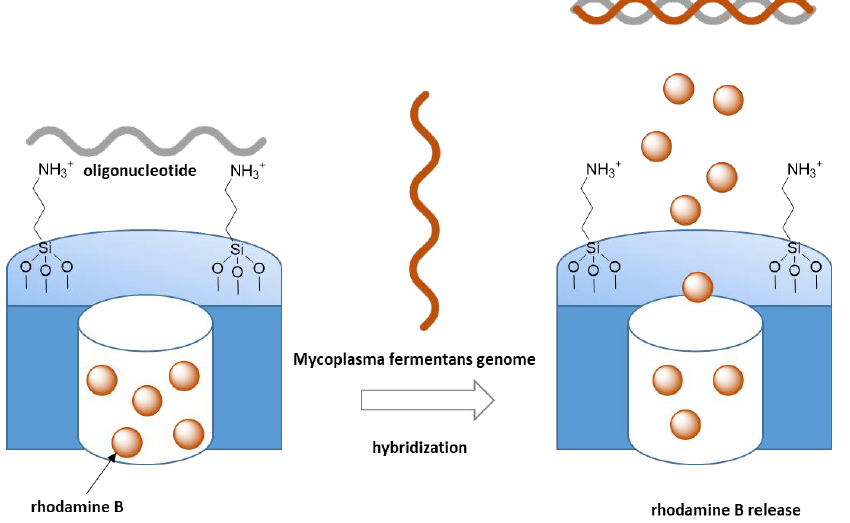
Figure 5. Capped mesoporous silica materials for the selective detection of genomic DNA from bacteria ( Mycoplasma fermentans ). The presence of complementary oligonucleotide promoted the hybridization reaction and a displacement of the cap resulting in pore opening and dye delivery. Adapted with permission from Ref [93]. Copyright 2019, MDPI, Basel, Switzerland.